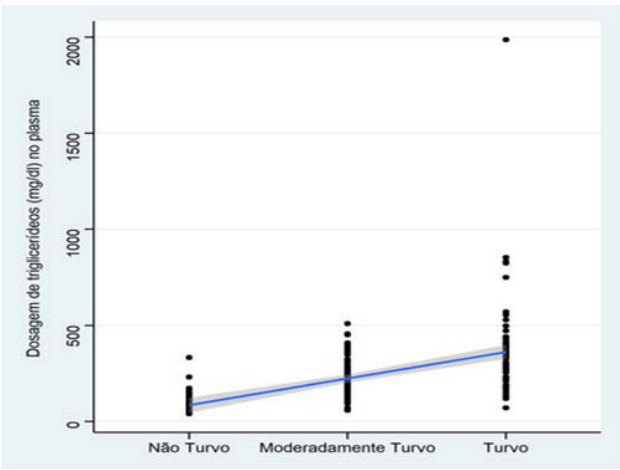
fIGuRE 2 – Scatter diagram of the relationship between visual inspection and dosages serum (2A) and plasma (2B) triglycerides. Footnote: Figure 2A - Serum (r=0.57) and Figure 2B - Plasma (r=0.52). Source: The authors